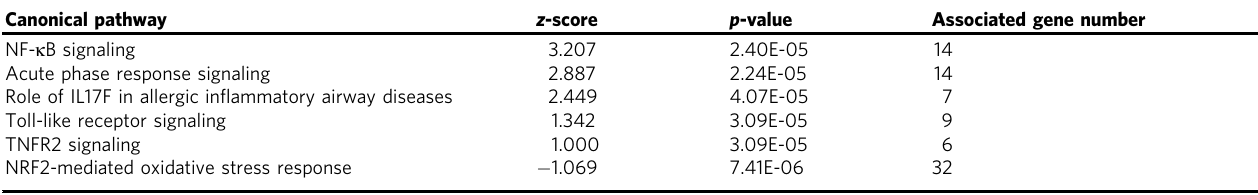
Table 1 Enriched canonical pathways of differentially expressed